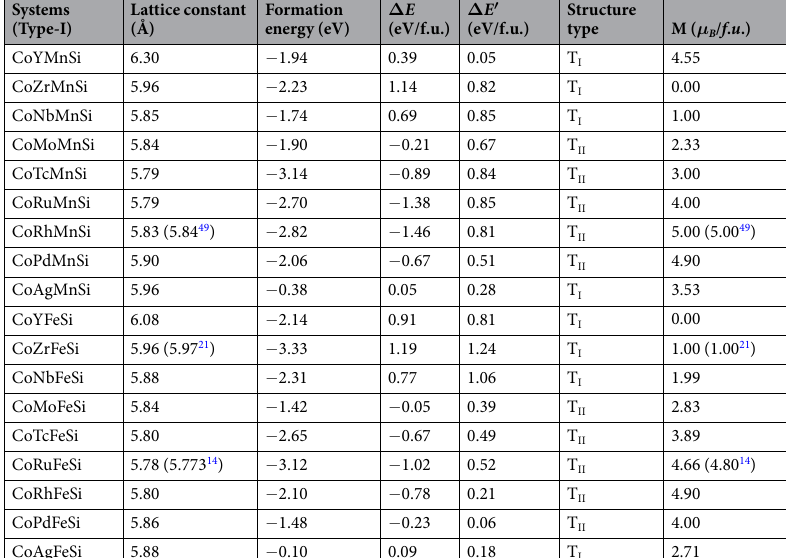
Table 2. Calculated lattice constants, formation energies, magnetic moments and energy differences between possible structures of quaternary CoX ′ Y ′ Si compounds. The energy differences between Type-II (T II ) and Type-I (T I ) structures are given by Δ E = E differences between Type-III (T III ) and Type-I or Type-II structures are given by Δ E ′ = E systems which crystallise in Type- II (T II ), Δ E ′ = E Δ E ′ = E − E T III T I